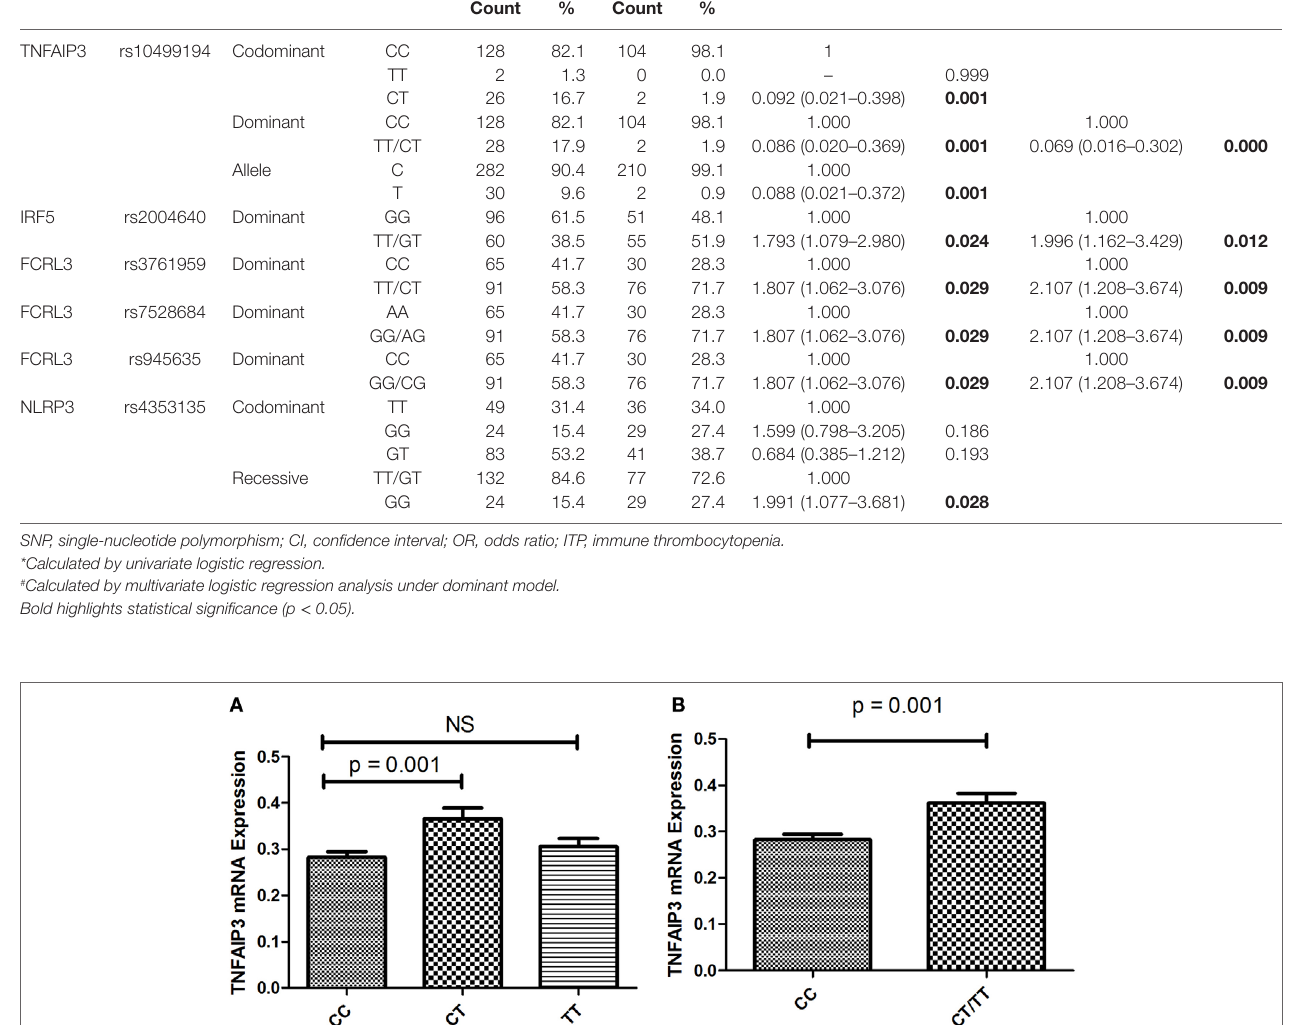
TaBle 6 | Association between selected SNPs and corticosteroid-sensitivity of ITP patients.